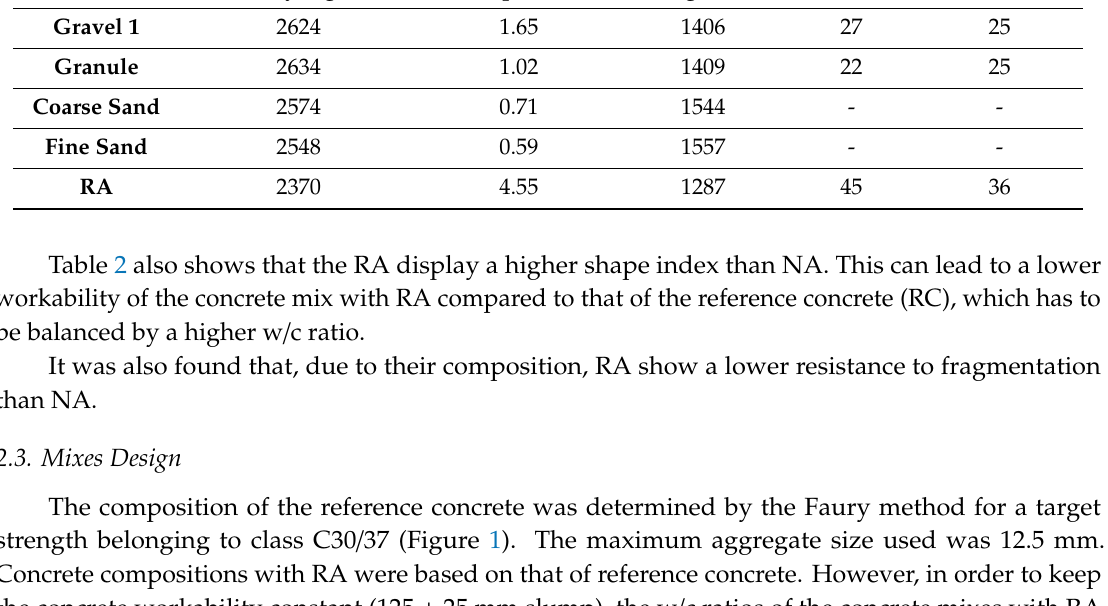
Table 2. Physical properties of the aggregates.